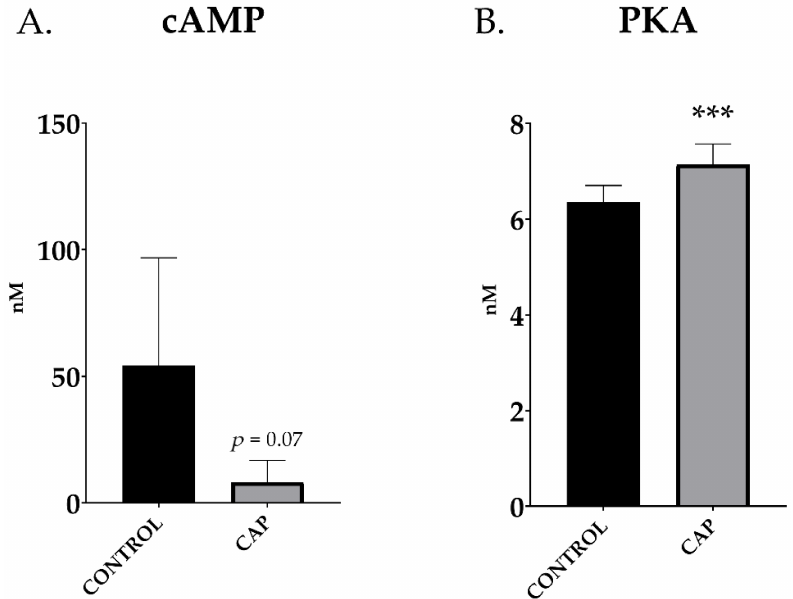
Figure 2. cAMP levels ( A ) and PKA levels ( B ) in control (CONTROL) and in vitro capacitated (CAP) boar ejaculated spermatozoa ( n = 5). The results are shown as mean ± SEM. * depicts significant differences between CONTROL and CAP (*** p < 0.001).